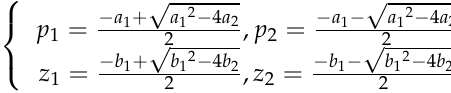
Figure 9. DC load line is superimposed on the V–I plane.